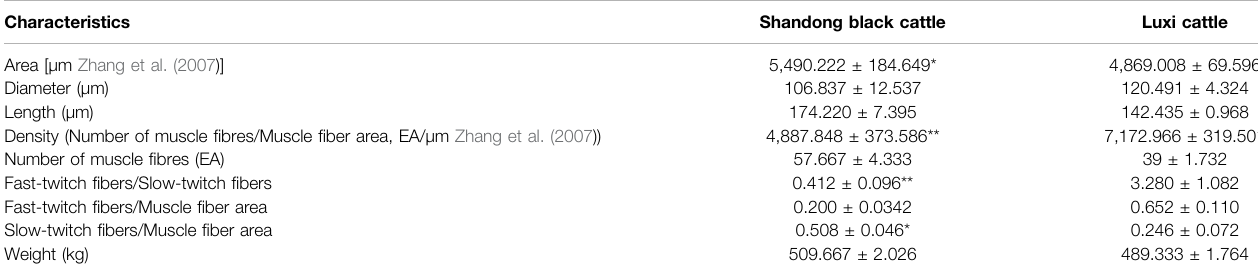
TABLE 1 | Comparison of muscle fi bre characteristics and growth characteristics of different breeds of cattle.